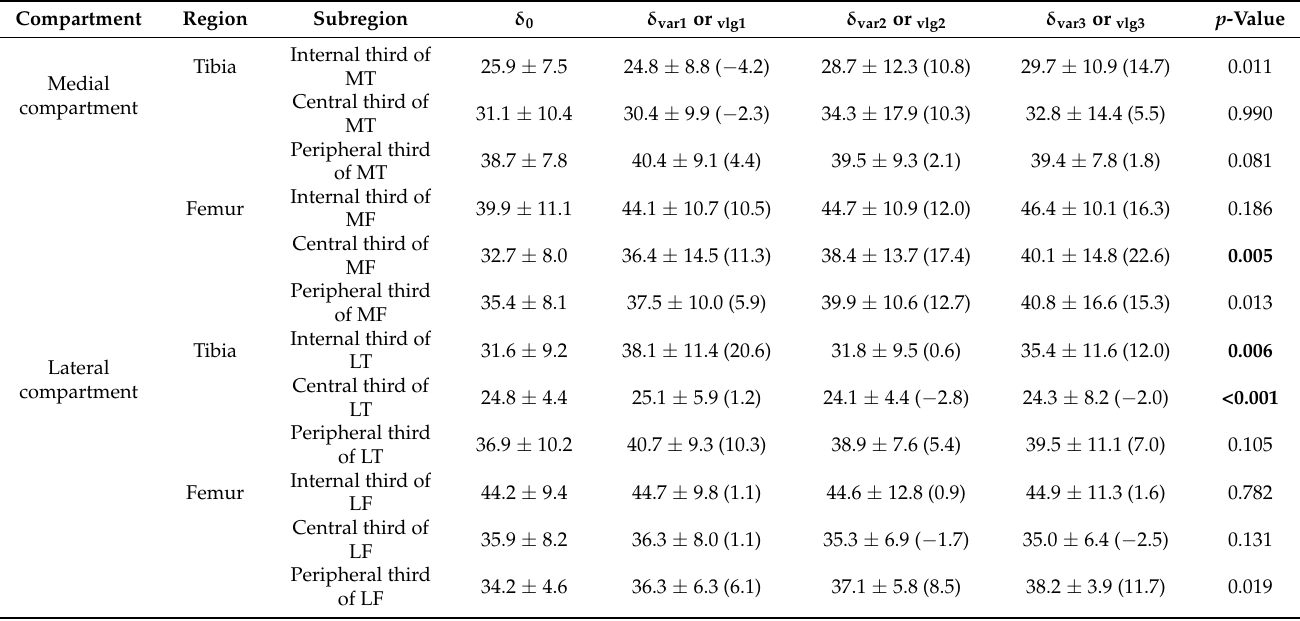
Table A3. Mean absolute T2 relaxation times of femoral and tibial cartilage subregions in response to loading. Mean ± standard deviation (ms) (mean percentage change versus δ 0 (%)). Statistical analysis was performed using Friedman’s test and statistically significant findings are highlighted in bold type . Please refer to Table 2 for additional details on table